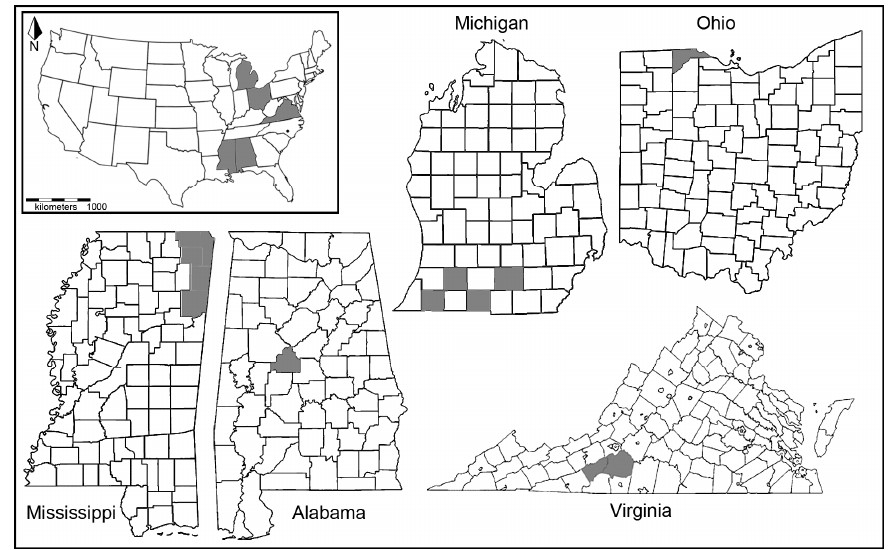
Figure 1. State and county distributions of N. mitchellii . Insert of Unites States of America shows states with N. m. mitchelli present in grey, and a black dot for N. m. francisci presence. Grey regions reflect counties N. m. mitchelli were sampled for this study. Black filled circle in North Carolina denotes Fort Bragg that N. m. francisci is present.